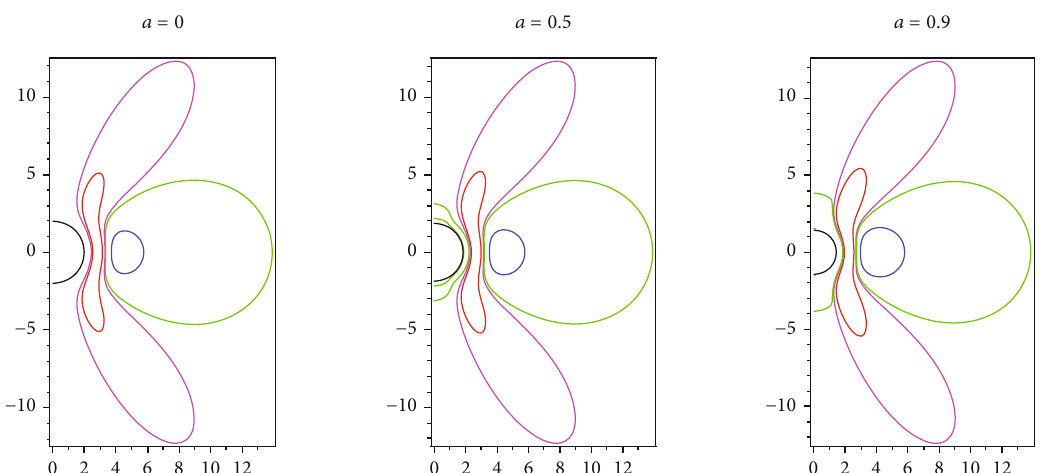
Figure 5: Contour plots of constant charge density lines according to (35). They correspond to the assumptions given in Example 2 for three di ff erent values of the Kerr parameter a . Red lines are for ρ = 0 : 01 , blue for ρ = − 0 : 01 , magenta for ρ = 0 : 001 , and green for ρ = − 0 : 001 ; the black curve represents the black hole ’ s horizon.